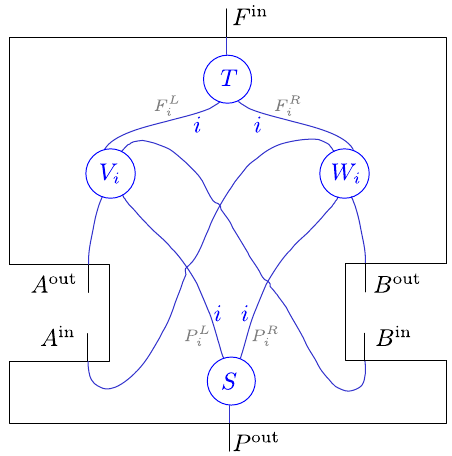
Fig. 7 Extended circuit diagram decomposition of the quantum SWITCH. Additionally indicated in grey are the labels of the intermediate families of